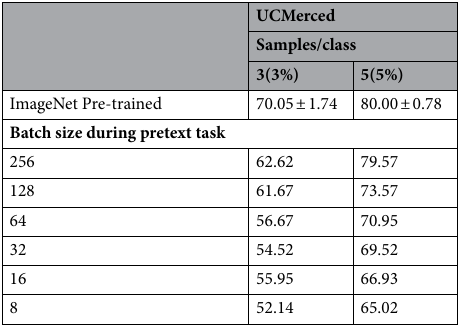
Table 2. Classification accuracy values obtained using UCMerced dataset as the batch size is varied from 256 down to 8.